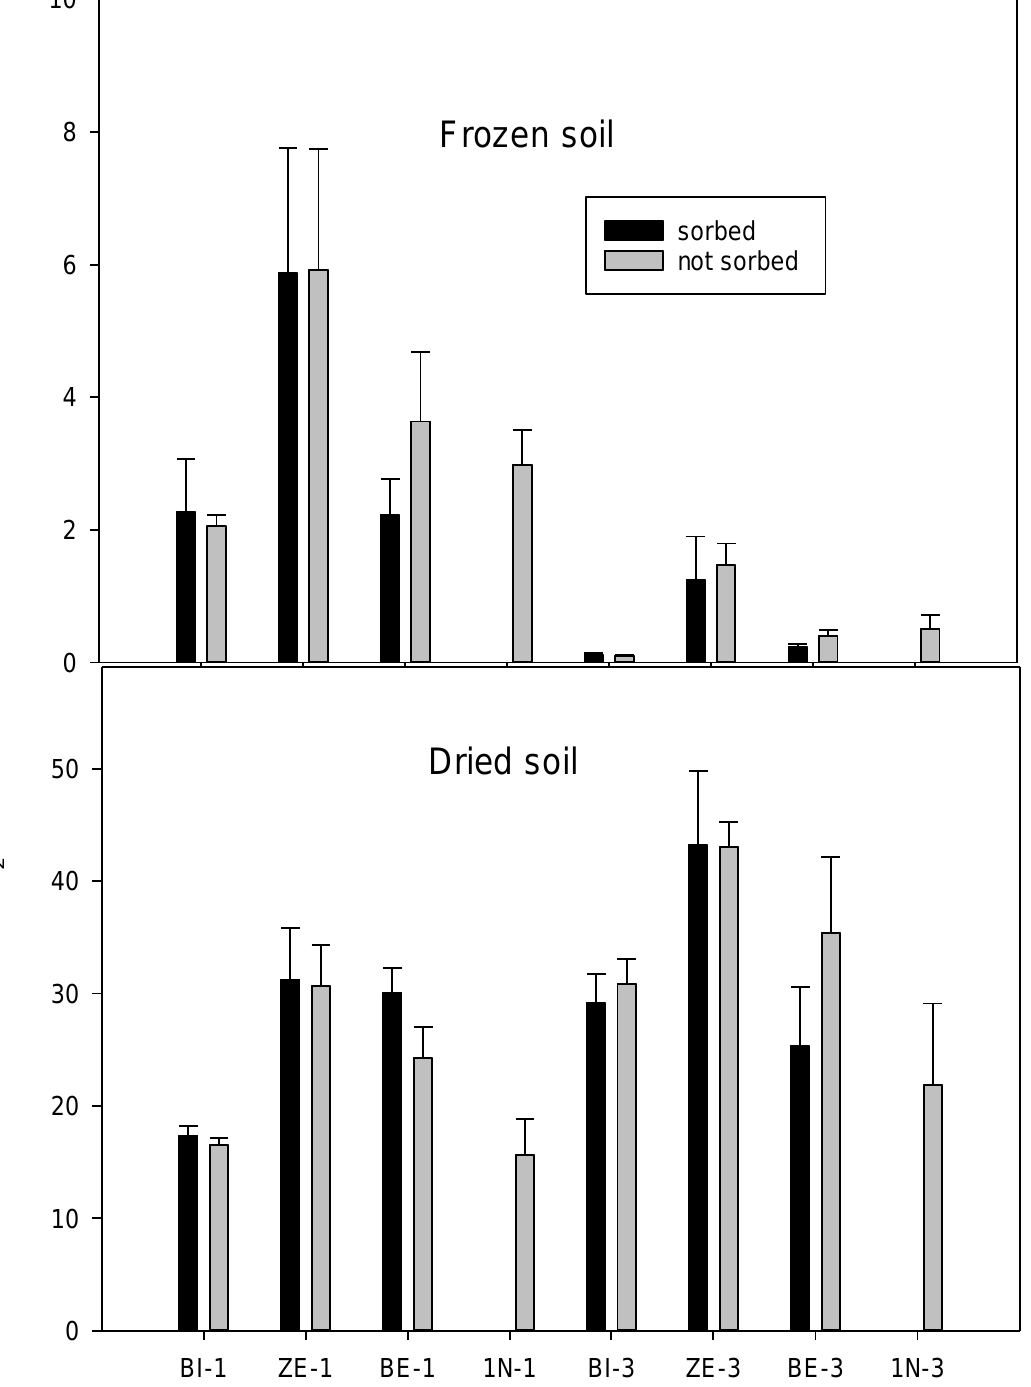
Figure 6. Percentage of N 2 O -N originating from the applied fertiliser on day 1 (shown as -1) and day 3 (shown as -3) of the incubation. Error bars are standard error (n = 3). BI = biochar sorbent, ZE = zeolite sorbent, BE = bentonite sorbent. -1 means day 1, -3 means day 3.